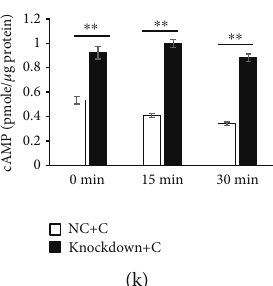
Figure 5: Adra2a knocking down increases the expression and secretion of growth factors in T2D ASCs. Representative micrographs of T2D ASCs and T2D ASCs with lentivirus. Green represents lentivirus successfully transfected into the cells (a, b). The levels of expression of Adra2a from T2D ASCs transfected with Adra2a knockdown lentivirus and negative control lentivirus (c). The expression of VEGF (d), HGF (e), and TGF- β (f) in the NC, NC+C, knockdown, and knockdown+C group at 24 h, 48 h, and 72 h, respectively. The secretion of VEGF (g), HGF (h), and TGF- β (i) in the NC, NC+C, knockdown, and knockdown+C group at 24 h, 48 h, and 72h, respectively. The change of cAMP and PKA in T2D ASCs after Adra2a knocking down (j, k): the contents of cAMP (j) and activities of PKA (k) at 0min, 5min, and 15min with 10 μ M clonidine treatment. Note: NC: Negative control, T2D ASCs transfected with control vectors; knockdown: Adra2a knocked-down T2D ASCs; NC+C: Negative control T2D ASCs treated with 10 μ M clonidine; knockdown+C: Adra2a knocked- down T2D ASCs treated with 10 μ M clonidine. Three biological replicates and three technical replicates were used in each case. ∗ P < 0 : 05 ; ∗∗ P < 0 : 01